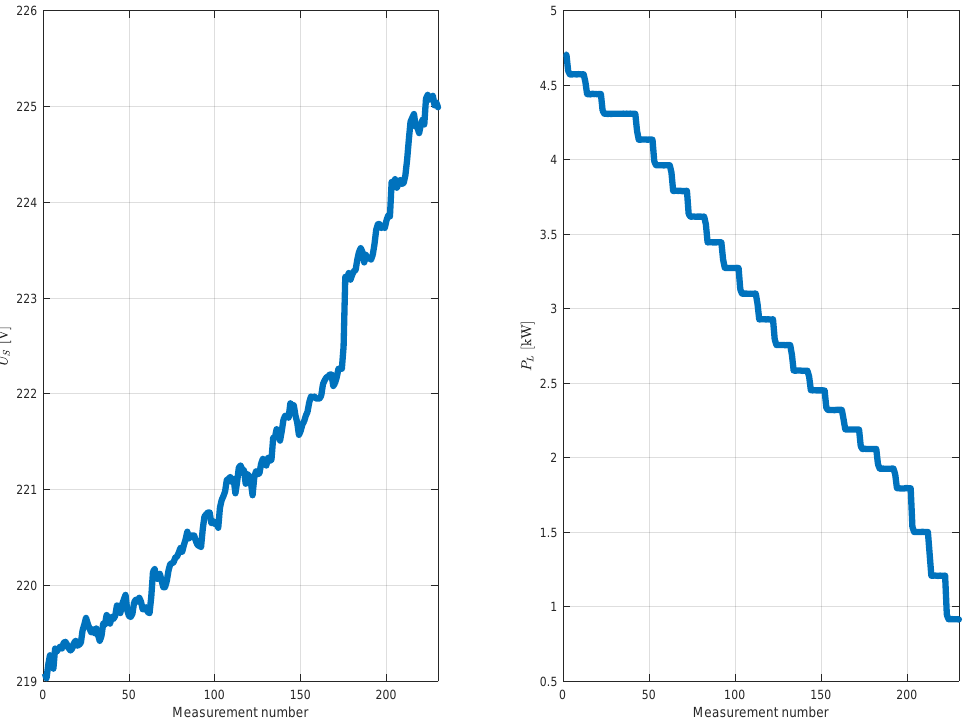
Figure 18. Results from test laboratory environment for decreasing P L